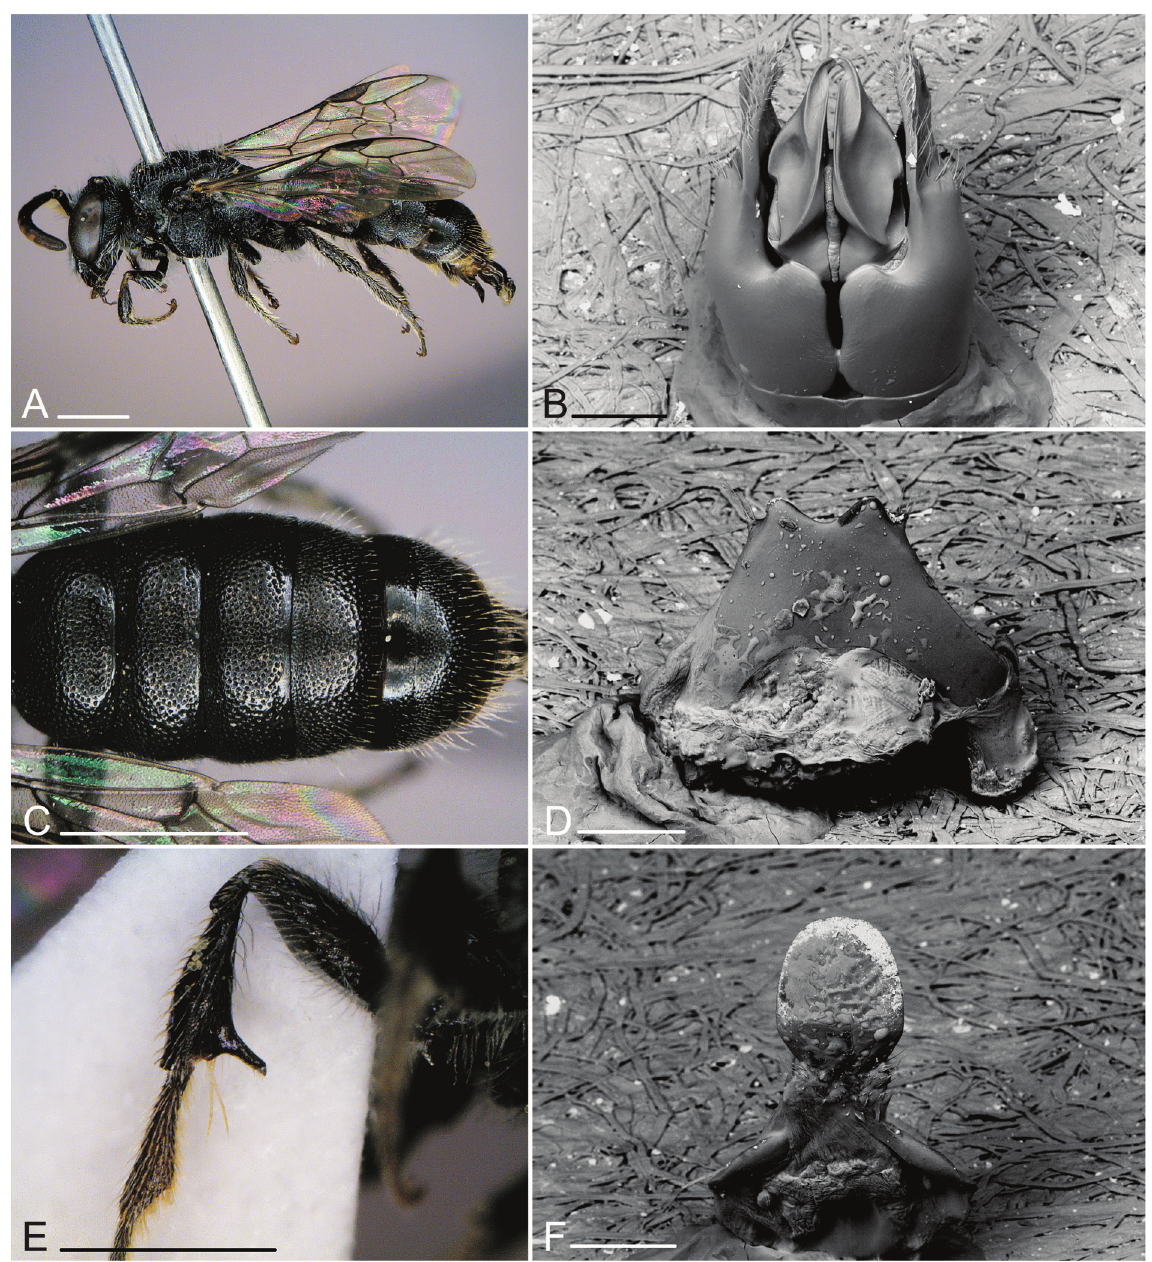
Fig. 31. Scrapter spinipes sp. nov., ♂. A . Lateral view. B . Genitalia (dorsal view, SEM). C . Metasoma (dorsal view). D . S7 (dorsal view, SEM). E . Hind tibia. F . S8, apical end (SEM). Scale bars: photos: 1 mm, SEM: 0.1